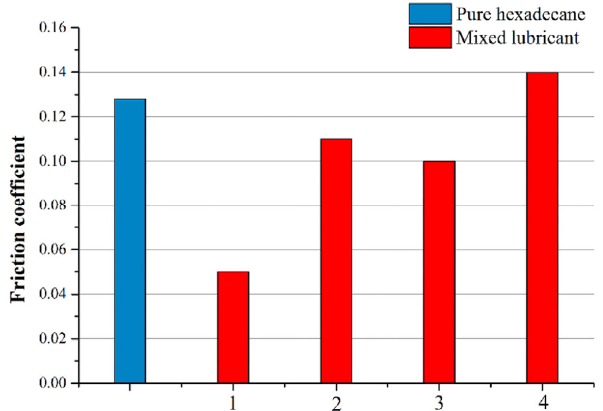
Fig. 5 Friction coefficient of pure hexadecane and Lubricant 1 −